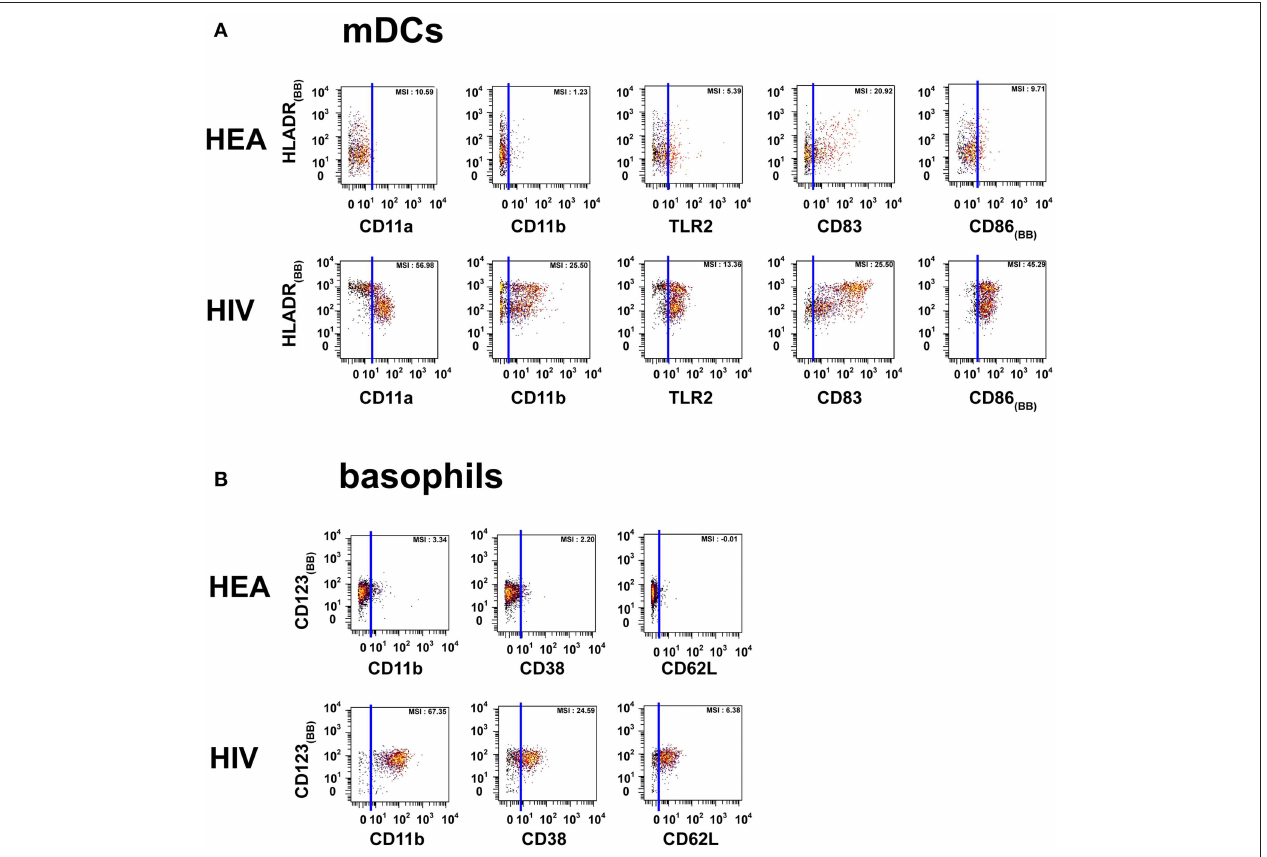
FIGURE 2 | Dot plots representing the phenotypes of mDCs and basophils from HIV-infected patients and healthy donors. Cell clusters corresponding to mDCs were isolated based on the same SPADE analysis presented in Figure 1 . The same approach was used to isolate basophils. (A) Biplot representations showing the co-expression of HLADR and either CD11a, CD11b, CD83, CD86, or TLR2 by mDC populations. (B) Biplot representations showing the co-expression of CD123 and either CD11b, CD38, or CD62L by basophil populations. Blue lines were added to better visualize the difference in marker expression between healthy donors and HIV-infected patients. MSI represents the mean (MSI) of the markers in the X axes. “BB” in subscript indicates backbone